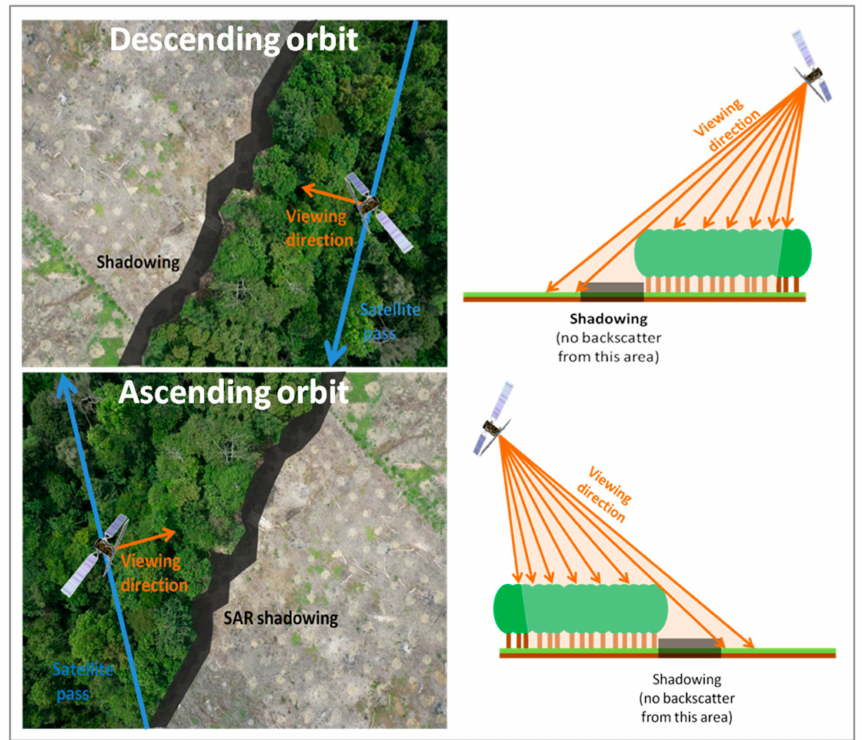
Figure 3. Illustration of the synthetic aperture radar (SAR) shadowing effect at the border between forests and deforested areas, for the descending and ascending orbit configurations. (Background image: ConservationDrones.org/Orangutan